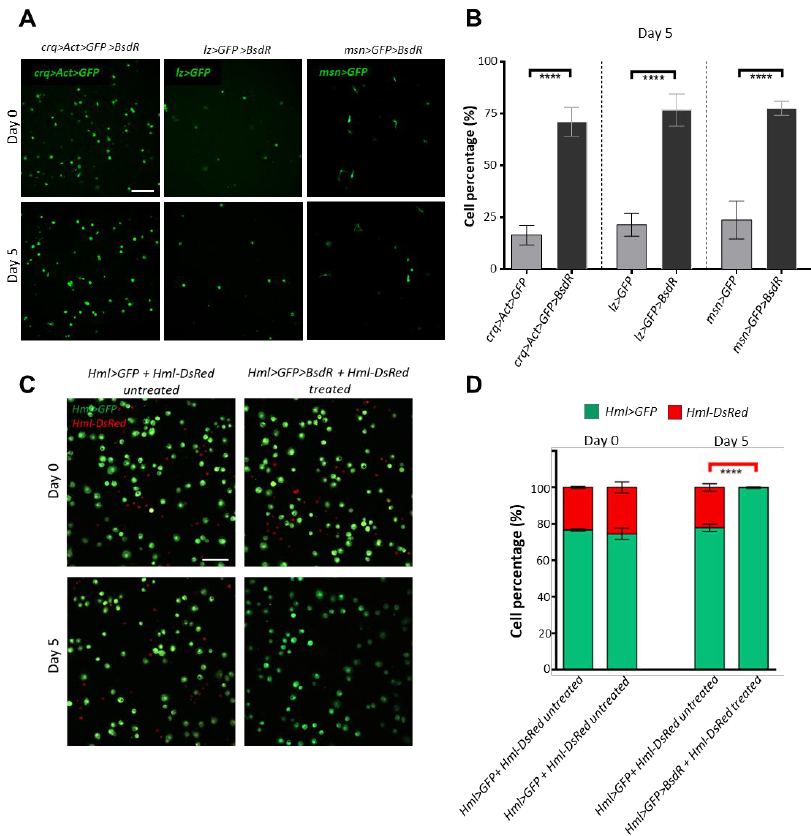
Figure 5. A blasticidin selection system for hemocyte subsets cultured ex vivo. ( A ) Representative images of crq>Act>GFP>BsdR , lz>GFP>BsdR and msn>GFP>BsdR cultures on Day 0 and Day 5 after